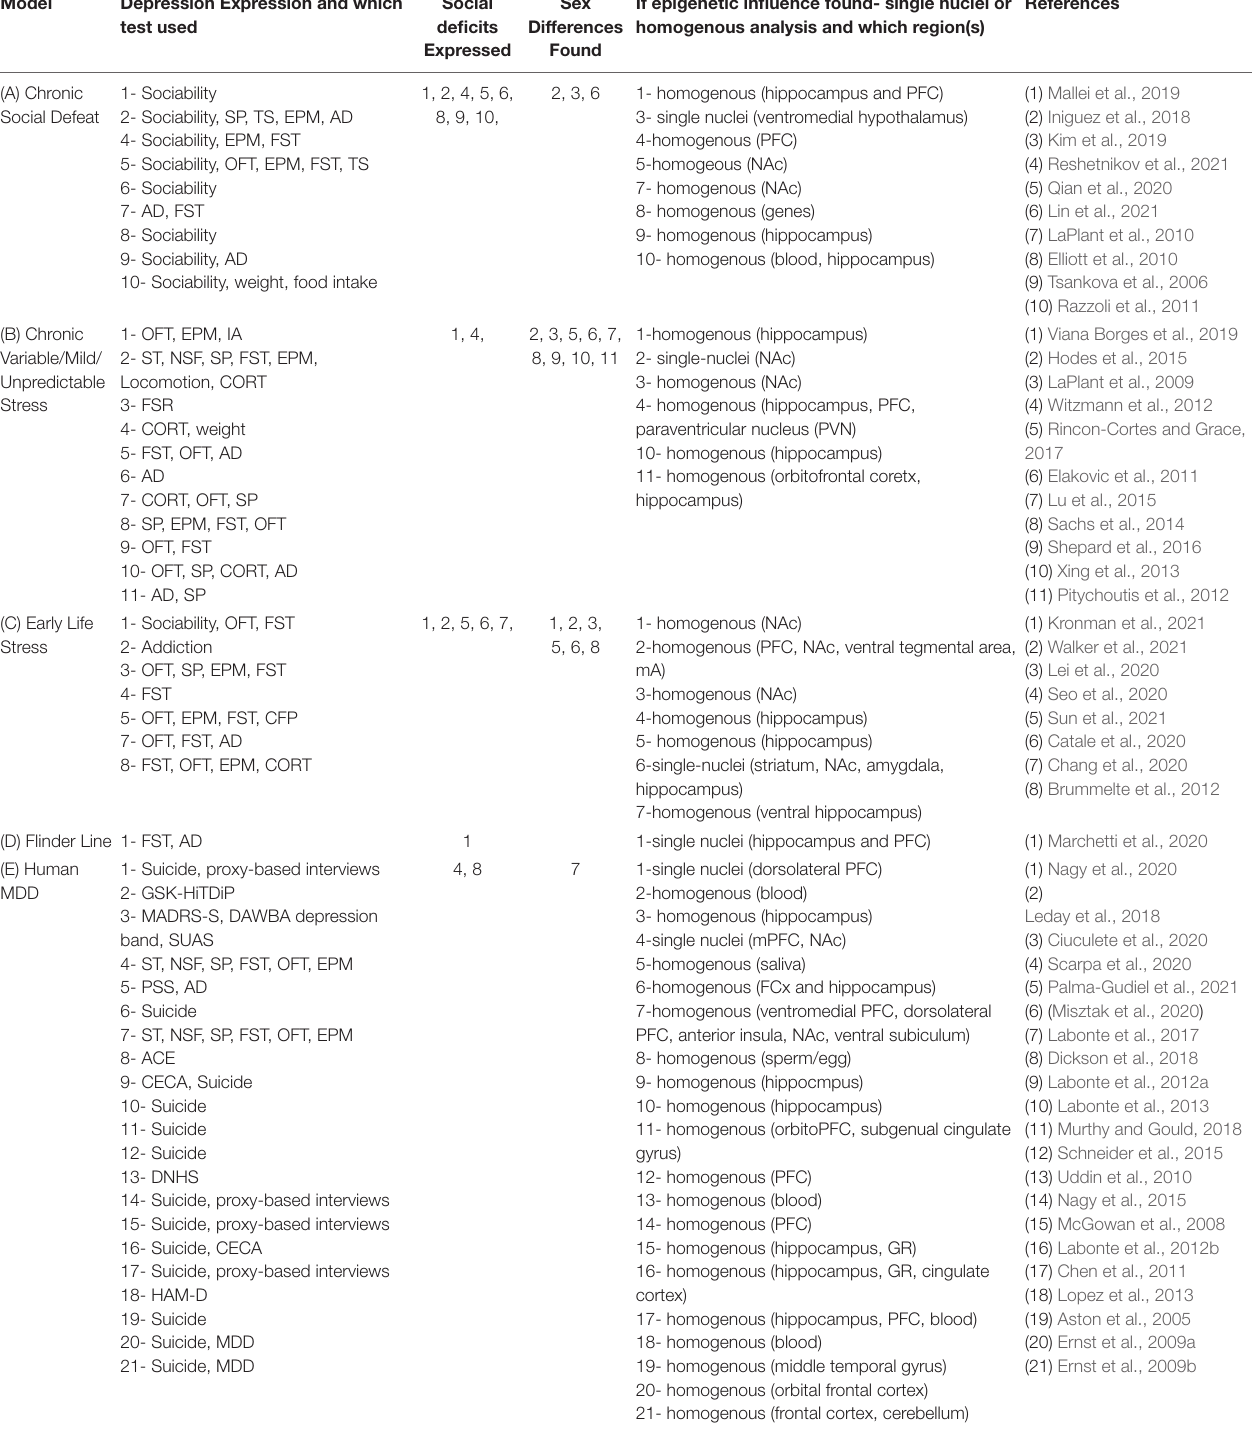
TABLE 1 | Comparisons of most epigenetics studies on rodent models and human MDD.